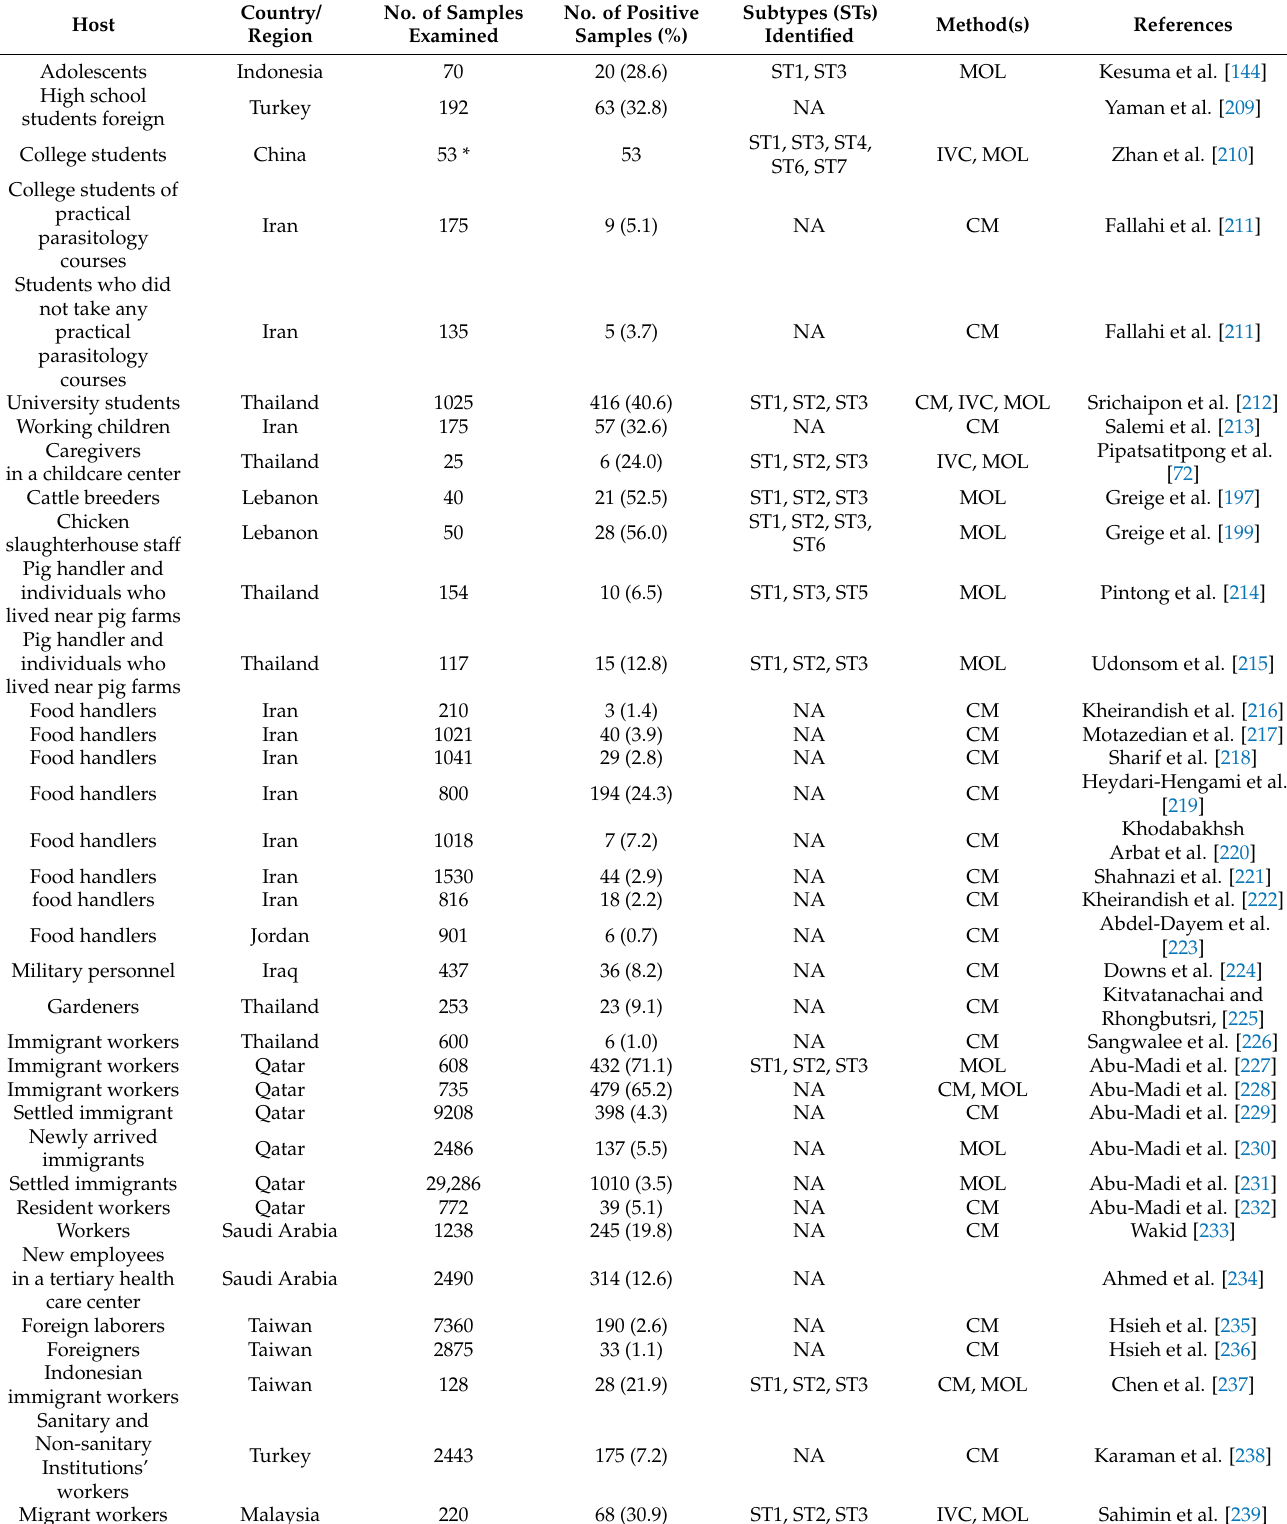
Table 6. Prevalence and subtype distribution of Blastocystis spp. in students and working populations in Asia (2010–2021).